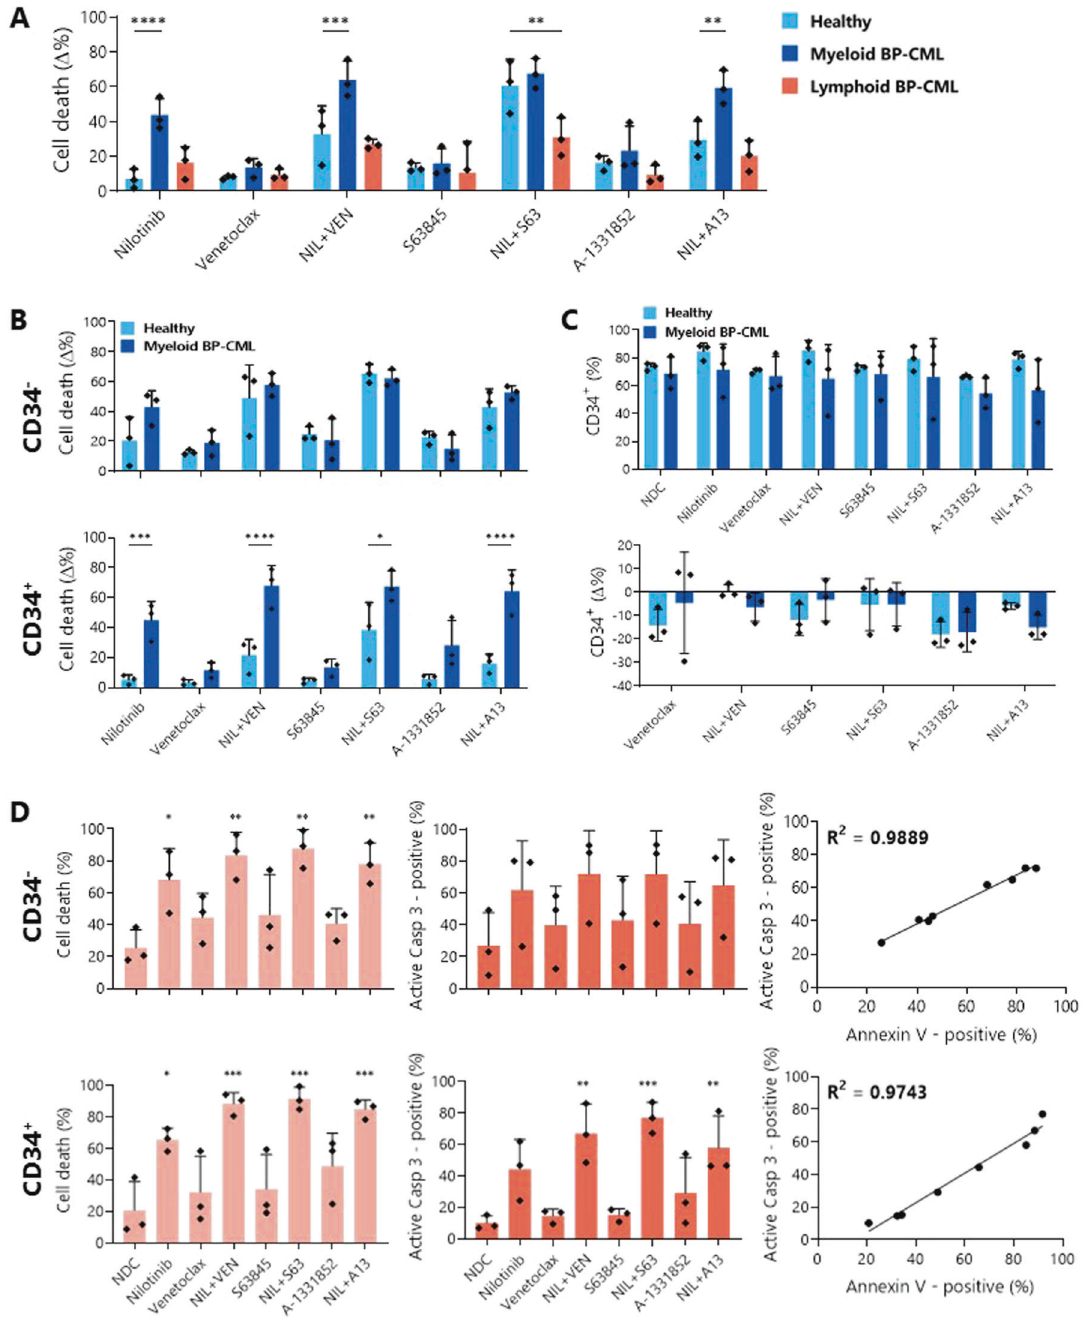
Fig. 8 BH3 mimetics enhance the apoptotic effect of nilotinib in myeloid BP-CML patients and discriminately kill primitive CD34 + BP- CML cells. Three healthy, three myeloid BP-CML, and three lymphoid BP-CML patient samples were treated with 5 µM nilotinib and/or 1 µM BH3 mimetic as indicated for 72 h before Annexin V/DAPI staining in the bulk cell population ( A ), and in the CD34 - and CD34 + fractions of three healthy and three myeloid BP-CML samples ( B ). C After the same treatment, three healthy and three myeloid BP-CML samples were tested for CD34-positivity, expressed as a percentage of the whole cell population (top) and as a change compared with nilotinib alone (bottom; C ). A , B and C analyzed by two-way ANOVA. D Apoptosis was con fi rmed by staining for Annexin V/DAPI (light orange) and active caspase-3 (dark orange) in CD34 - and CD34 + myeloid BP-CML cells after 72 h treatment with 5 µM nilotinib and/or 1 µM BH3 mimetics and correlation between both was determined, N = 3, analyzed by one-way ANOVA. NIL nilotinib, VEN venetoclax, S63 S63845, A13 A-1331852. * p ≤ 0.05, ** p ≤ 0.01, *** p ≤ 0.001, **** p ≤ 0.0001. Data are represented as mean ± SD. lines BV173 and CML-T1 were highly sensitive to all BH3 mimetics and BCL-xL, with signi fi cant degrees of apoptosis induced, tested. As previous TKI exposure is likely to affect BH3 mimetic particularly after dual-inhibition. sensitivity, it would also be worth investigating whether other TKIs Interestingly, combining BH3 mimetics with the TKI nilotinib in combination with BH3 mimetics may be a potent therapeutic was not a successful strategy for inducing apoptosis in lymphoid option in lymphoid BP-CML. Dual targeting of prosurvival BCL-2 BP-CML samples. This was surprising, as the lymphoid BP-CML cell Cell Death Discovery (2022)